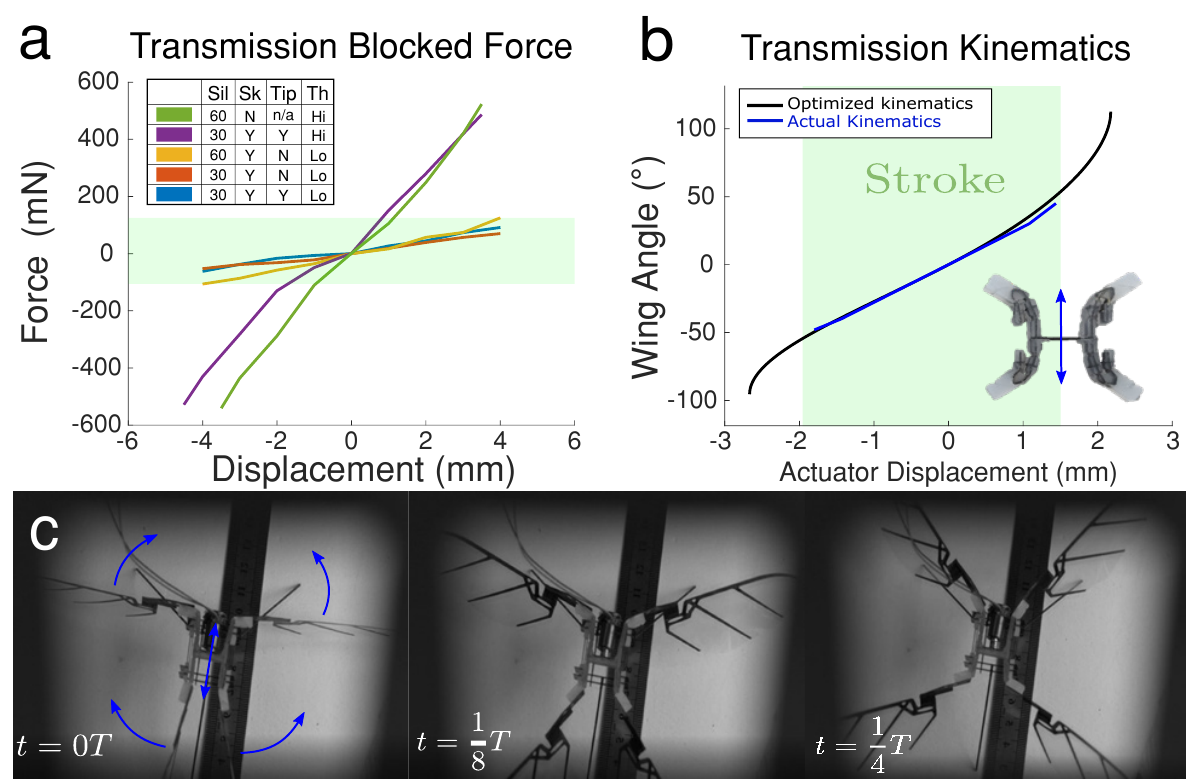
Figure 6. Dynamics and kinematics of the silicone transmission. ( a ) Blocked force necessary to induce displacements for different designs of the transmission (see text). ( b ) Transmission kinematics, with a linear relationship between actuator displacement and flapping magnitude (blue) and optimized curve (black). ( c ) Video stills show wing motion over 1/4 of a period, T , using the linear voice coil